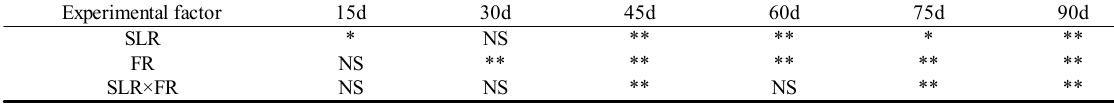
Figure 1. Effects of SLR and FR on plant height. Note: Bars represent means ± standard deviation ( n = 3) with different letters indicating significant differences based on LSD ( p ≤ 0.05). SLR, sugarcane leaf return; FR, fertilizer reduction. The symbols in the following tables and figures are the same as those appearing in this figure. The changes in maize stalk diameter in the whole growth stage were as shown in Figure 2. Except after 15 days, the effect of FR on maize stem diameter was significant ( p < 0.01). However, the interaction effect of SLR and FR combined treatment was just opposite. In the seedling stage, the variation in stalk diameter was insignificant in all nine treatment combinations ( p > 0.05). After 15 days, the effect of experimental treatments on stalk diameter began to appear gradually. The stalk diameter of maize plants under FF and HF condition was highly significant than that under the NF condition ( p < 0.05) after the seedling stage except after 15 days. Under the FF and HF conditions, a significant difference in the stalk diameter was not found between FS and HS treatments. Further, the stalk diameter after HSFF treatment was always more significant than that after HSHF